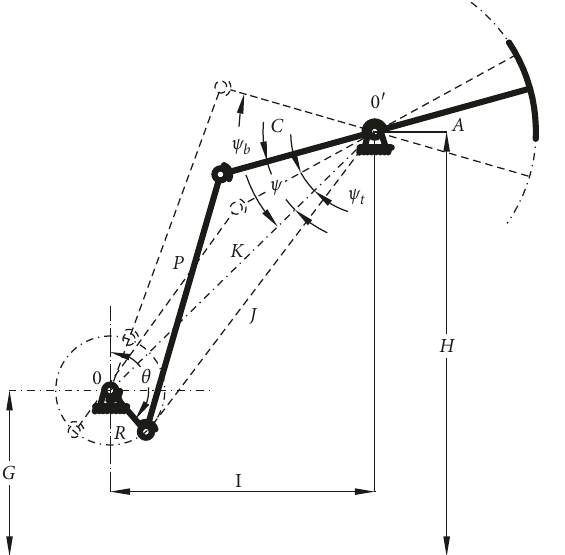
Figure 5: Sketch of the mechanism of the conventional beam pumping